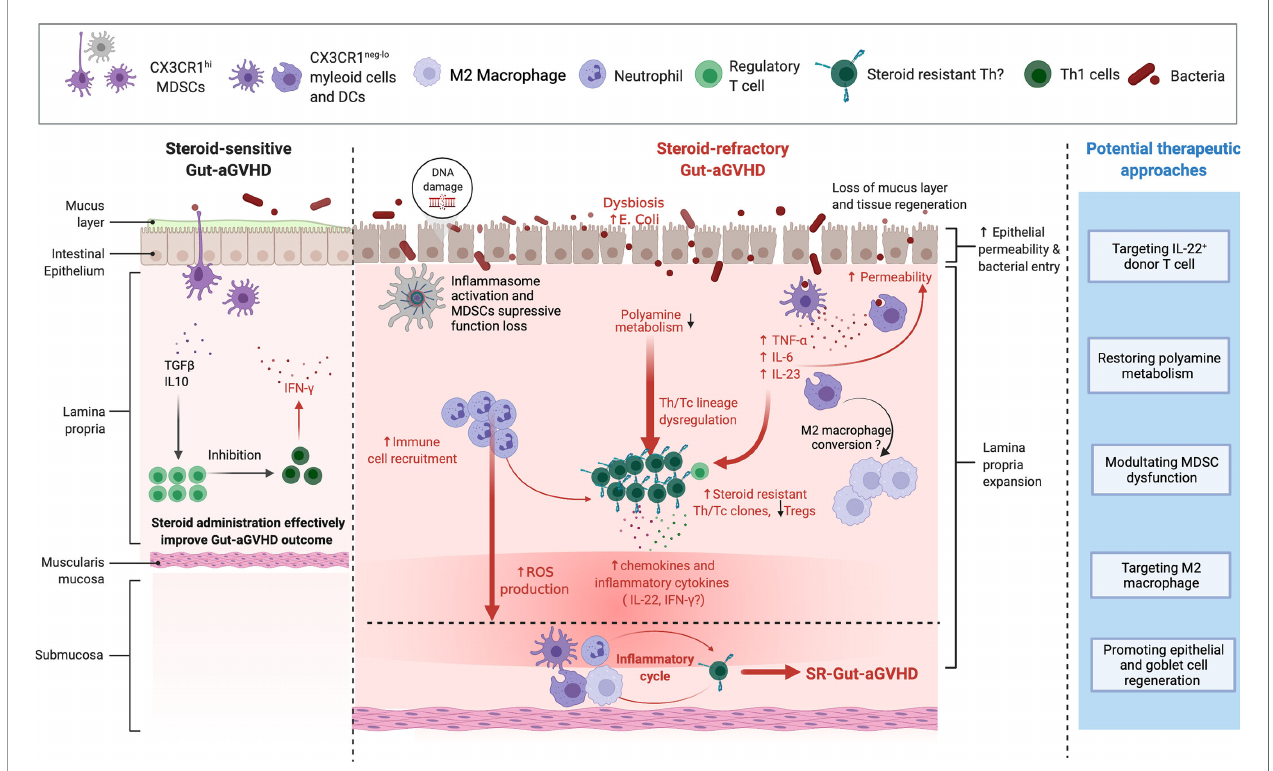
FIGURE 1 | Mechanism of steroid-refractory acute gut graft-versus-host disease (GVHD) (SR-Gut-aGVHD) and potential therapeutic approaches. With tissue damage due to conditioning, prolonged glucocorticoid (GC) treatment causes dysbiosis with expansion of pathogenic bacteria Escherichia coli . GC treatment may inhibit ornithine decarboxylase (ODC) activity in donor T cells resulting in the reduction of polyamine metabolites. At the same time, dysbiosis alters the microbiome metabolites, which may also lead to the reduction of polyamines. The reduction of polyamine metabolites causes Th lineage dysregulation and expansion of steroid-resistant Th/Tc clones that produce multiple proin fl ammatory cytokines (e.g., IL-22 and IFN- g ), along with the reduction of Tregs. Proin fl ammatory cytokines and chemokines such as IL-22 and IFN- g attract neutrophils and myeloid cells to in fi ltrate colon tissues. The presence of in fl ammatory cytokines, tissue DNA damage, and the activation of in fl ammasomes cause CX3CR1 hi mononuclear phagocytes (MNPs) to become in fl ammatory CX3CR1 lo/ − cells and subsequently drive myeloid-derived suppressor cells (MDSCs) to lose their ability to suppress in fl ammation. Loss of protective mucus layers, increase of intestinal epithelial permeability, and dysfunctional CX3CR1 hi MNPs allow bacterial invasion into the tissues, further triggering the production of in fl ammatory cytokines such as TNF a , IL-6, and IL-23, which further expand the steroid-resistant Th clones. In addition, GC treatment can also augment neutrophil migration and in fi ltration into the intestine and cause tissue damage via reactive oxygen species (ROS) production. Therefore, under prolonged GC treatment, the in fi ltrating T cells that produce IL-22 and/or IFN- g , as well as proin fl ammatory dendritic cells (DCs) and CX3CR1 neg-/lo myeloid cells and neutrophils, form a feed-forward pathogenic in fl ammatory cycle, resulting in full-blown SR-Gut-aGVHD. Based on these mechanisms, we propose the following potential therapeutic approaches: 1) targeting IL-22-producing donor T cell; 2) restoring polyamine metabolism; 3) modulating MDSC dysfunction; 4) targeting M2 macrophage; and 5) promoting epithelial and goblet cell regeneration. Figure is created with